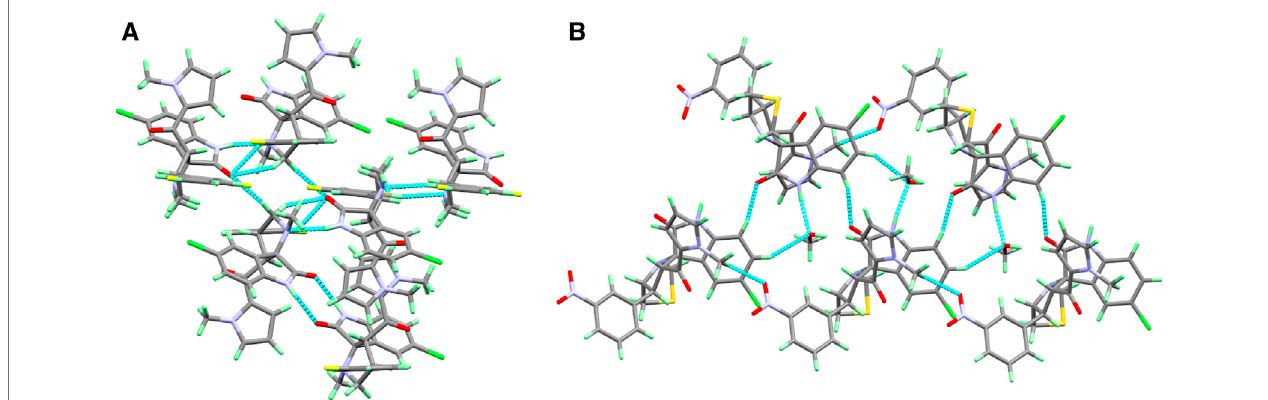
FIGURE 4 | Crystal packing diagram of compounds 2a and 2b .